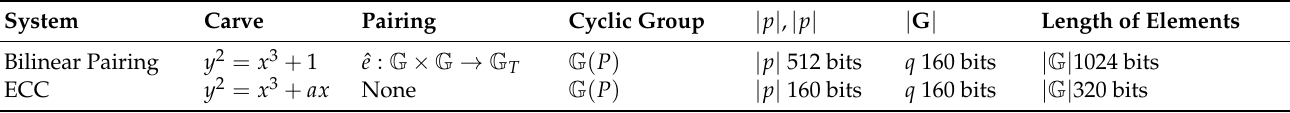
Table 7. Length of the group in bilinear pairing and